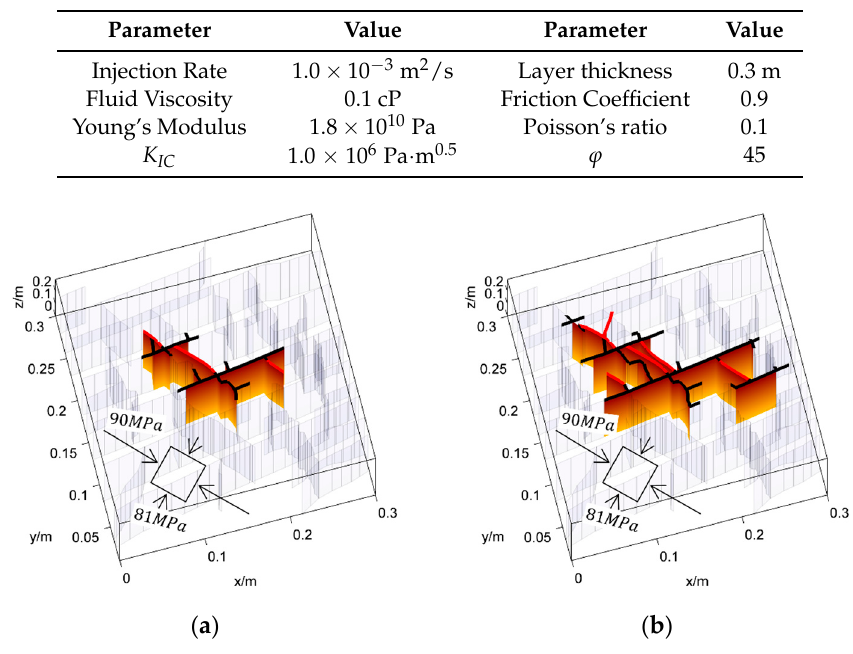
Figure 8. The numerical setting for simulating the propagation of complex fracture network. ( a ) The shale sample from Longmaxi formation of China; ( b ) The natural fracture network reconstructed from the shale sample. The natural fractures are represented by the light faces with blue lines on the top. The fluid is injected from the center of the region. Table 2. Input parameters for simulating the propagation of complex fracture network. Here K IC refers the mode I stress intensity factor of rock and ϕ is the angle between the maximum principle stress direction and the negative x -axis direction as illustrated in Figure 8b.